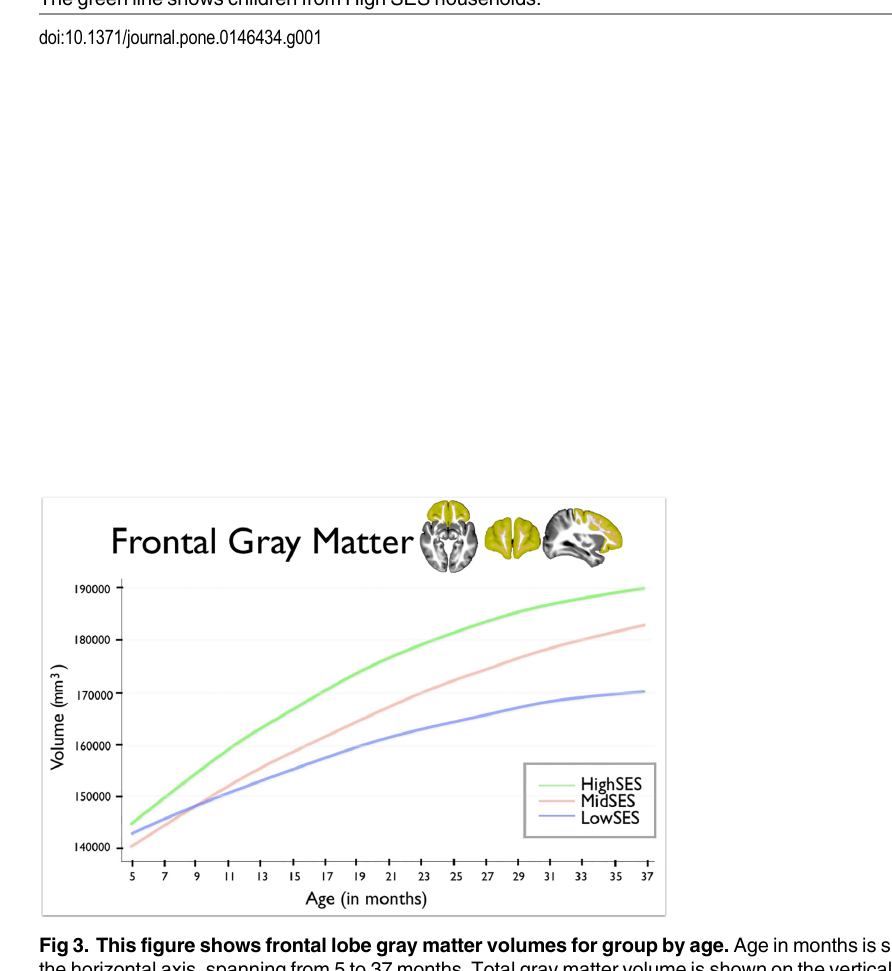
Fig 2. This figure shows total gray matter volume for group by age. Age in months is shown on the horizontal axis, spanning from 5 to 37 months. Total gray matter volume is shown on the vertical axis. The blue line shows children from Low SES households; children from Mid SES households are shown in red. The green line shows children from High SES households.